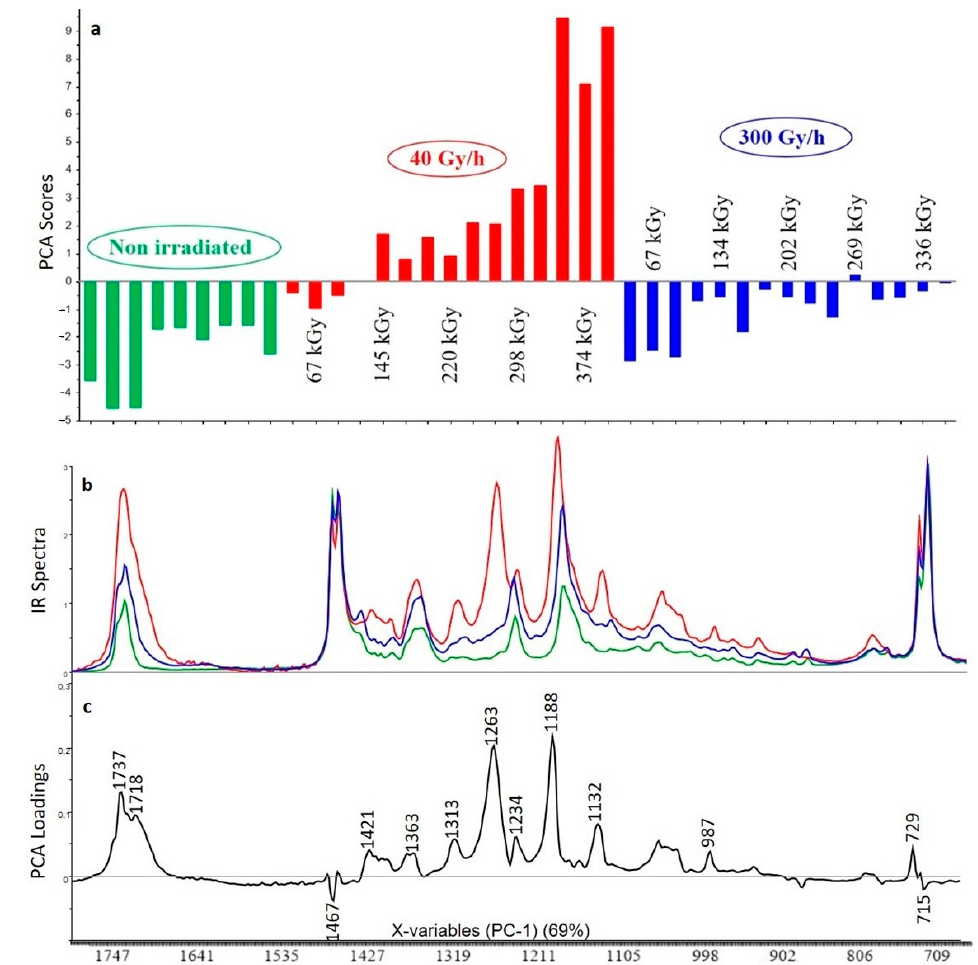
Figure 8. PCA scores ( a ), FTIR spectra for highest dose ( b ) and PCA loadings ( c ) of the first principal component (PC1) for the analysis of XLPE with Irganox 1076 and Irganox PS802 (green: unaged samples, red: samples irradiated at 40 Gy/h, blue: samples irradiated at 300 Gy/h).